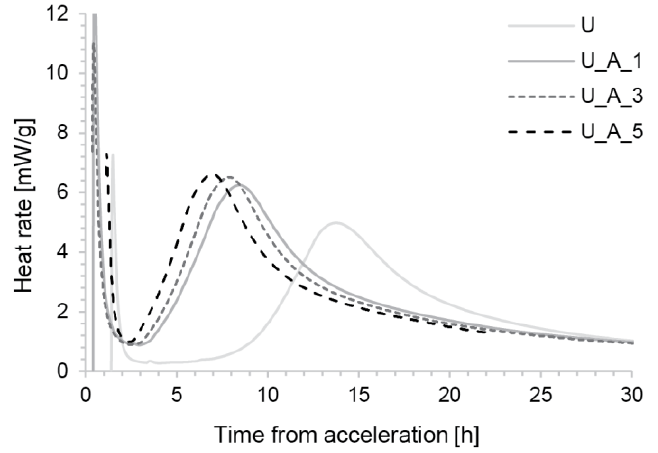
Figure 9. Heat flow over time from time of acceleration for the U mix accelerated with diluted aluminium sulfate solution.